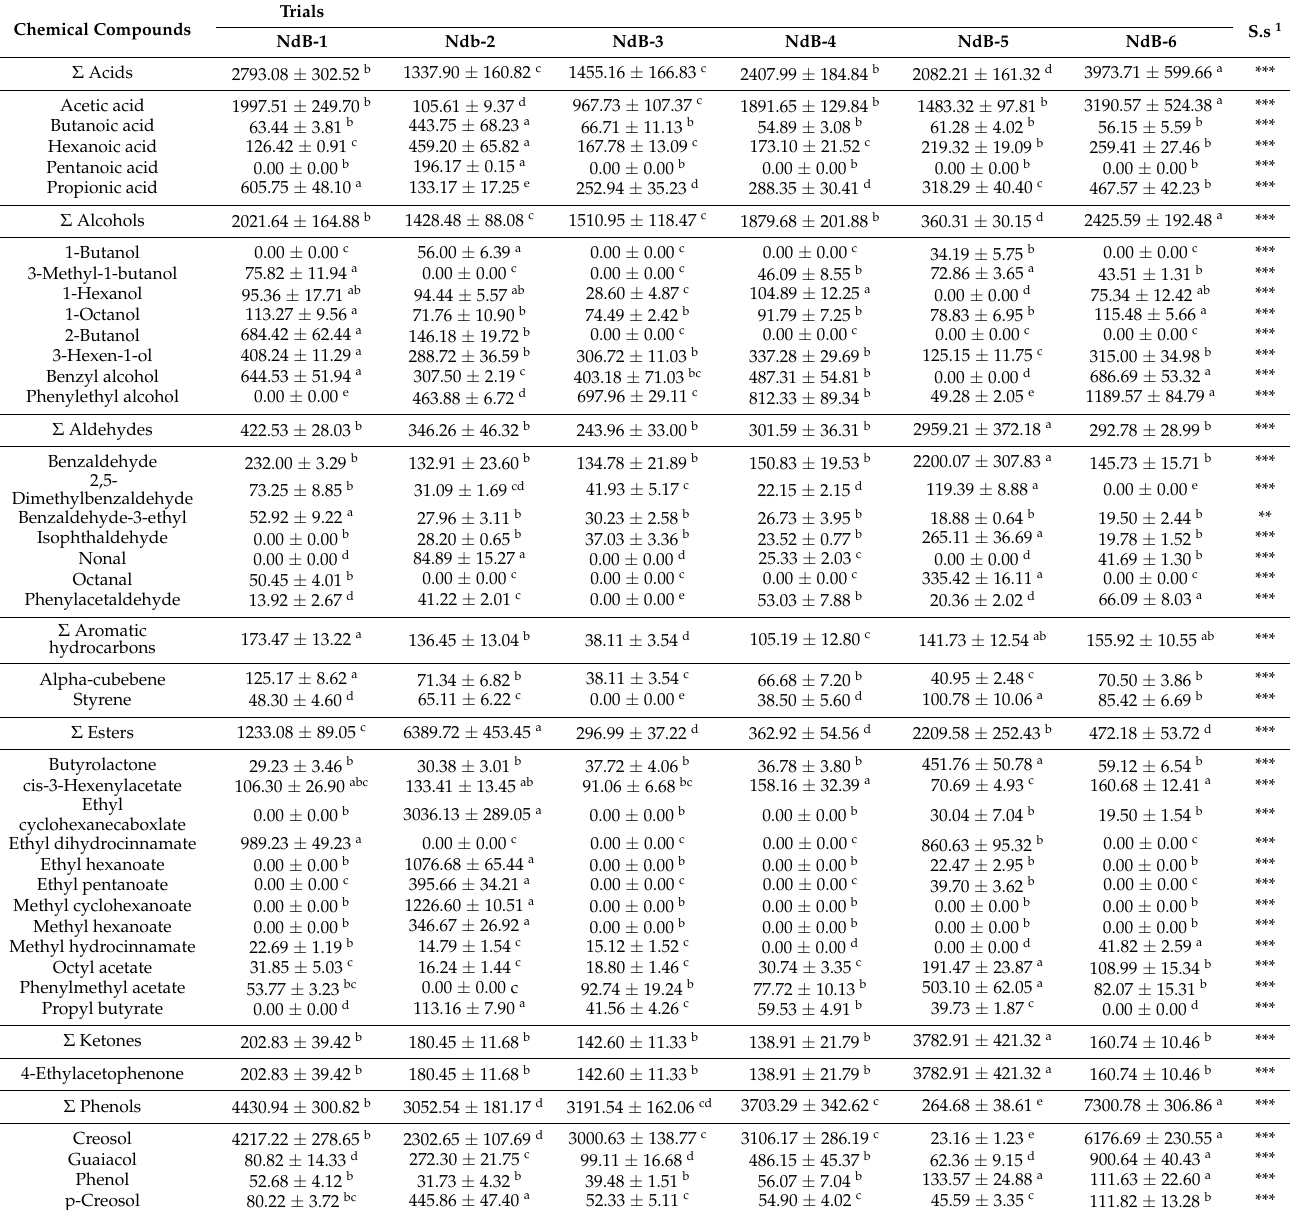
Table 3. Volatile organic compounds determined on the different experimental tests at the end of the production process (195